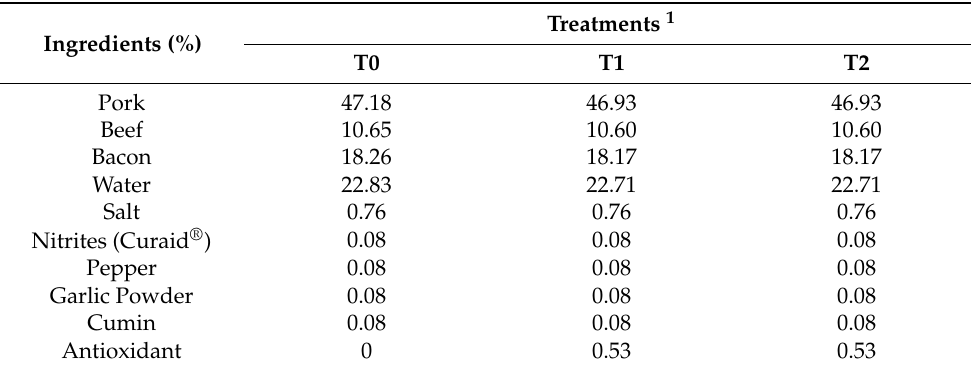
Table 2. Formulation of frankfurters with and without antioxidants (expressed as percentage of total